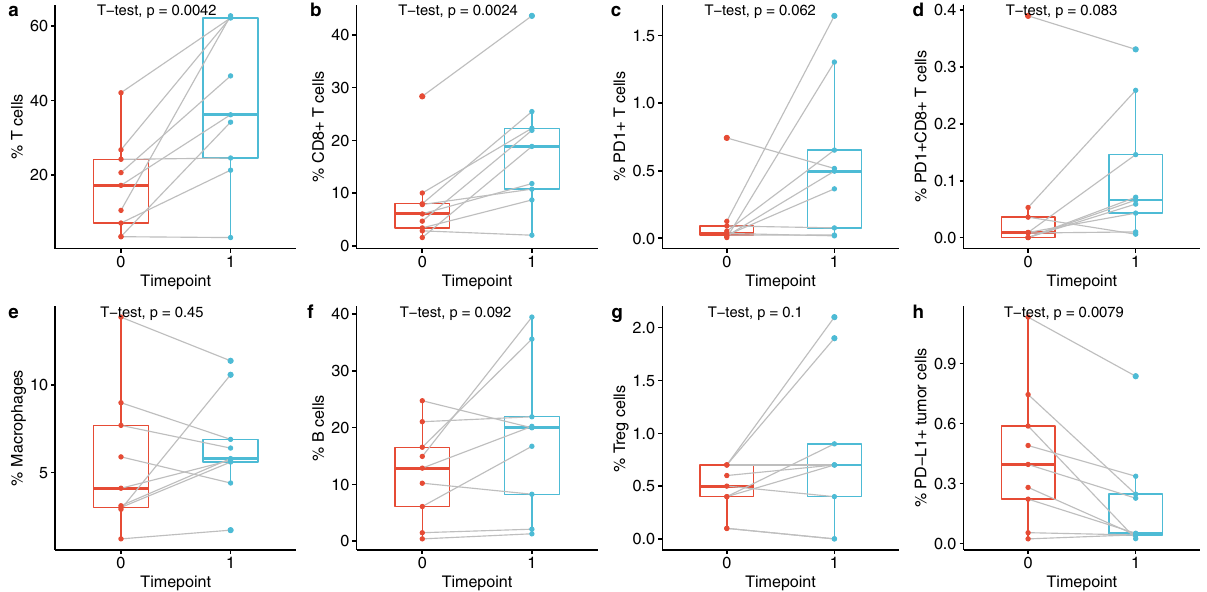
Fig. 3 Changes in immune cell populations in response to intralesional anti-PD-1 therapy. Cell densities pre-therapy (timepoint 0) and post-therapy (timepoint 1) are shown for ( a ) T cells, ( b ) cytotoxic T cells, ( c ) PD-1 + T cells, ( d ) PD-1 + cytotoxic T cells, ( e ) macrophages, ( f ) B cells, ( g ) regulatory T cells, and ( h ) PD-L1 + tumor cells. The bounds of each box represent the interquartile range (IQR). The horizontal line within a box is the median. Whiskers extend to the largest and smallest values no further than 1.5*IQR. Outlying points beyond the ends of the whiskers are plotted individually. Each pair of connected points represents one patient ’ s data; p -values derived from paired t